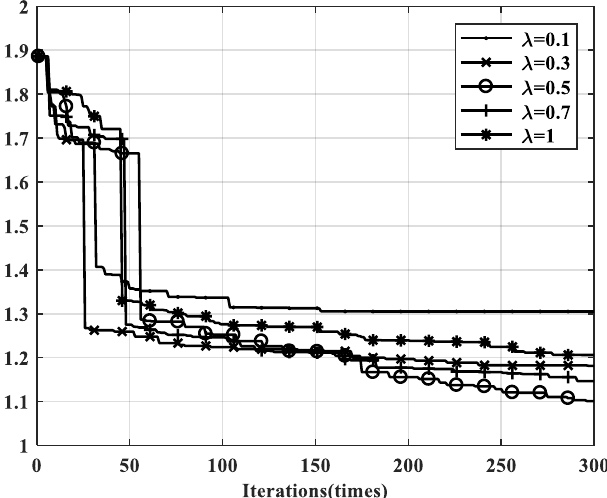
Figure 12. Impacts of the different regularization factors on the fitness error of the TVIPSO algorithm.